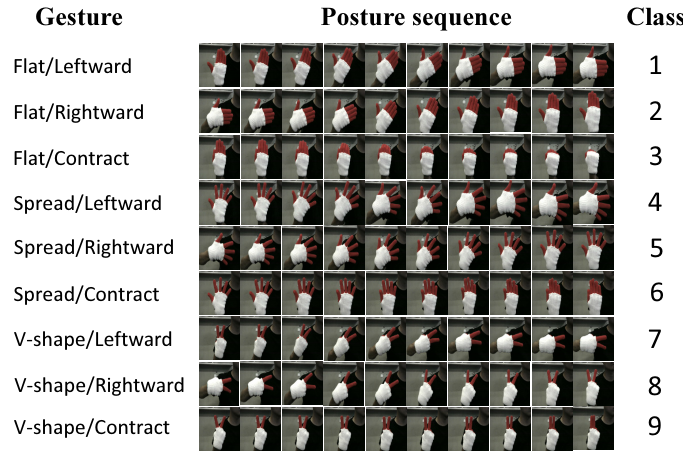
Figure 4. Nine types of gesture.